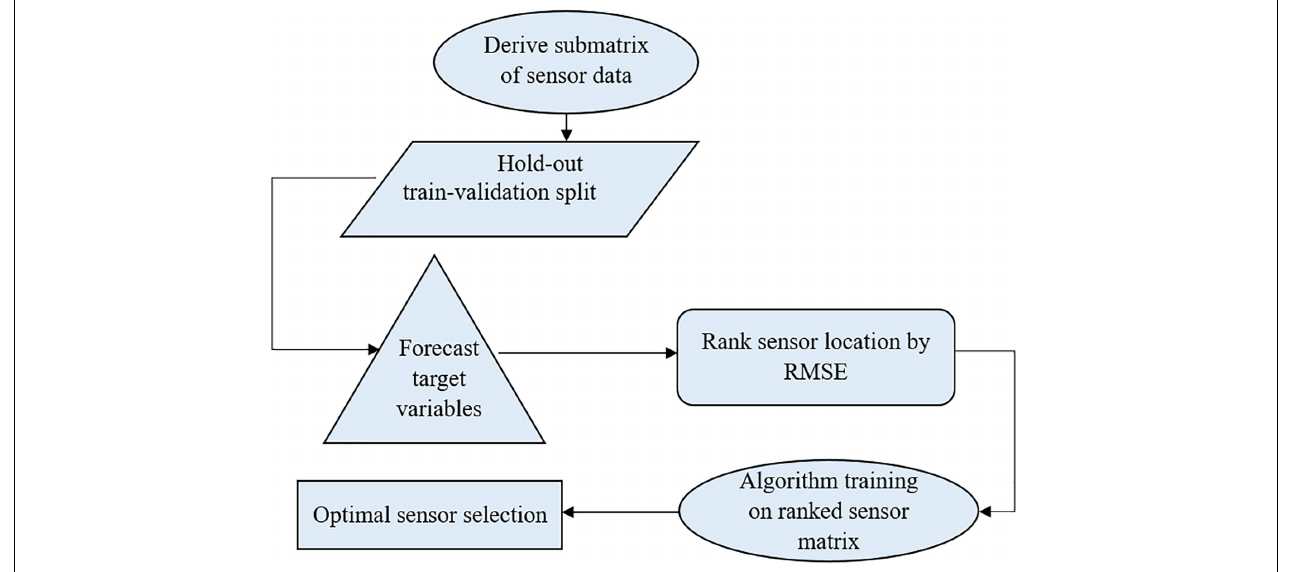
FIGURE 6 | Flow chart showing the summary of the model building process for optimal sensor selection.